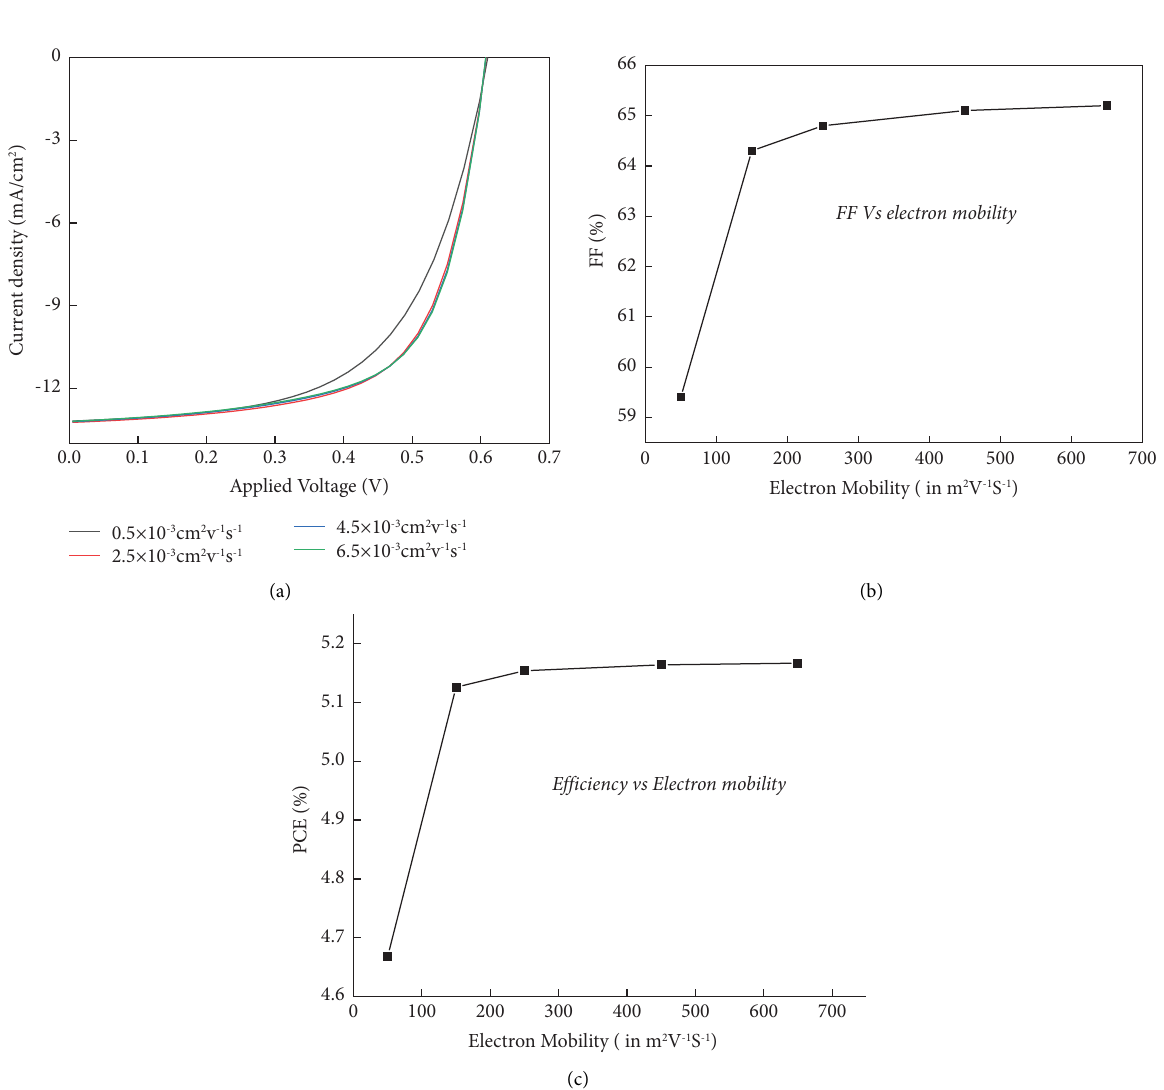
Figure 4: (a) Current density vs. applied voltage at diferent electron mobility. (b) FF vs electron mobility. (c) Efciency vs electron